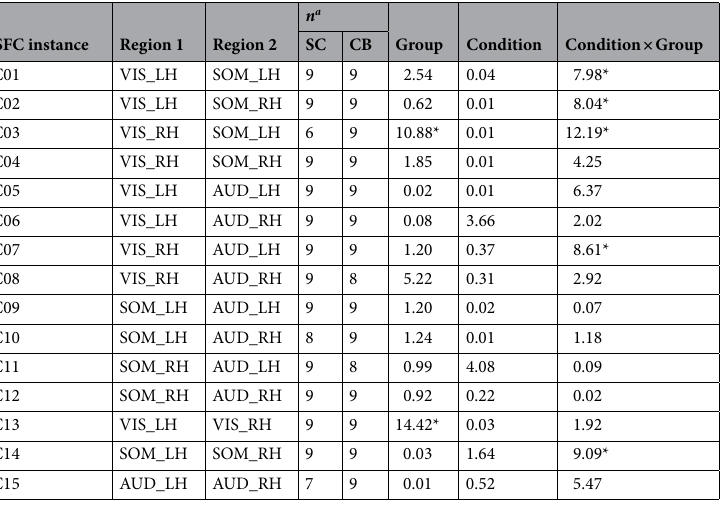
Table 2. Summary of statistical analyses ( F values) in Study 2. RSFC = resting-state functional connectivity; CB = congenitally blind; SC = sighted controls; FC = functional connectivity; VIS = visual region; LH = left hemisphere; SOM = somatosensory region; RH = right hemisphere; AUD = auditory region. a Sample size after outlier removal. * p < .050 (FDR